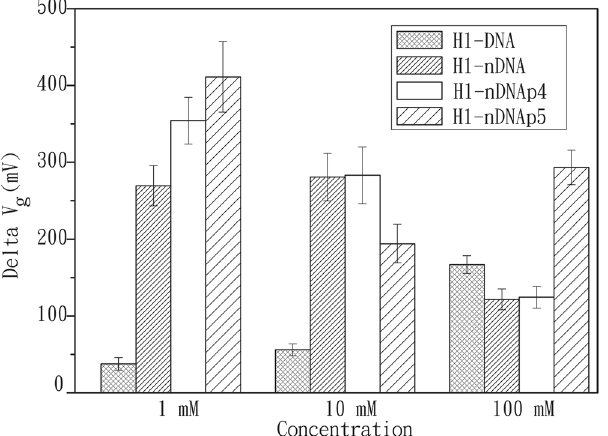
Figure 3. Gate voltage changes measured in 1, 10, and 100 mM BTP buffers. The signals were produced by the formations of H1-DNA/cH1, H1-nDNA/cH1 H1-nDNAp4/cH1, and H1-nDNAp5/cH1 duplexes. Target DNAs, cH1, and ncH1 were all prepared at 1